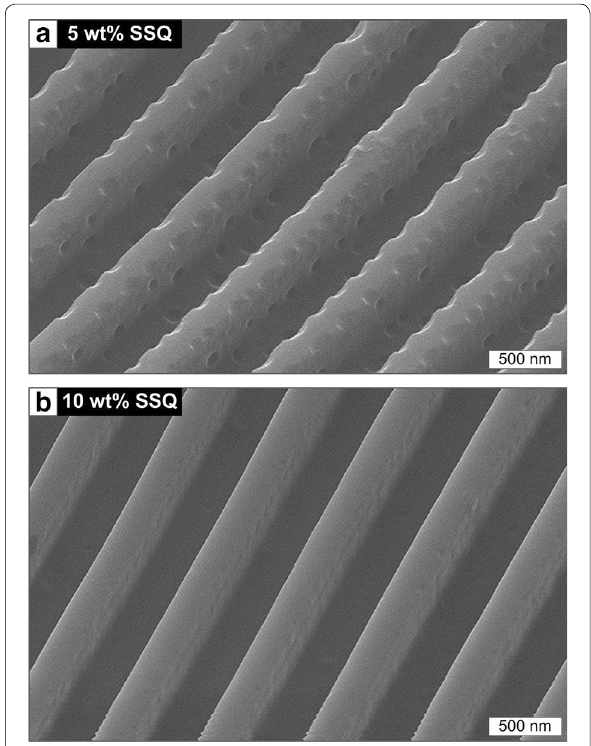
Fig. 2 Morphology difference depending on the resin concentration: nanopore generation. SEM images of R2R NIL-fabricated 700 nm- period nanograting patterns on the airbrushed SSQ resin films with different concentrations of a 5 wt% and b 10 wt%. The nanoscale pores are generated when 5 wt% SSQ is airbrushed while not found in the 10 wt% SSQ